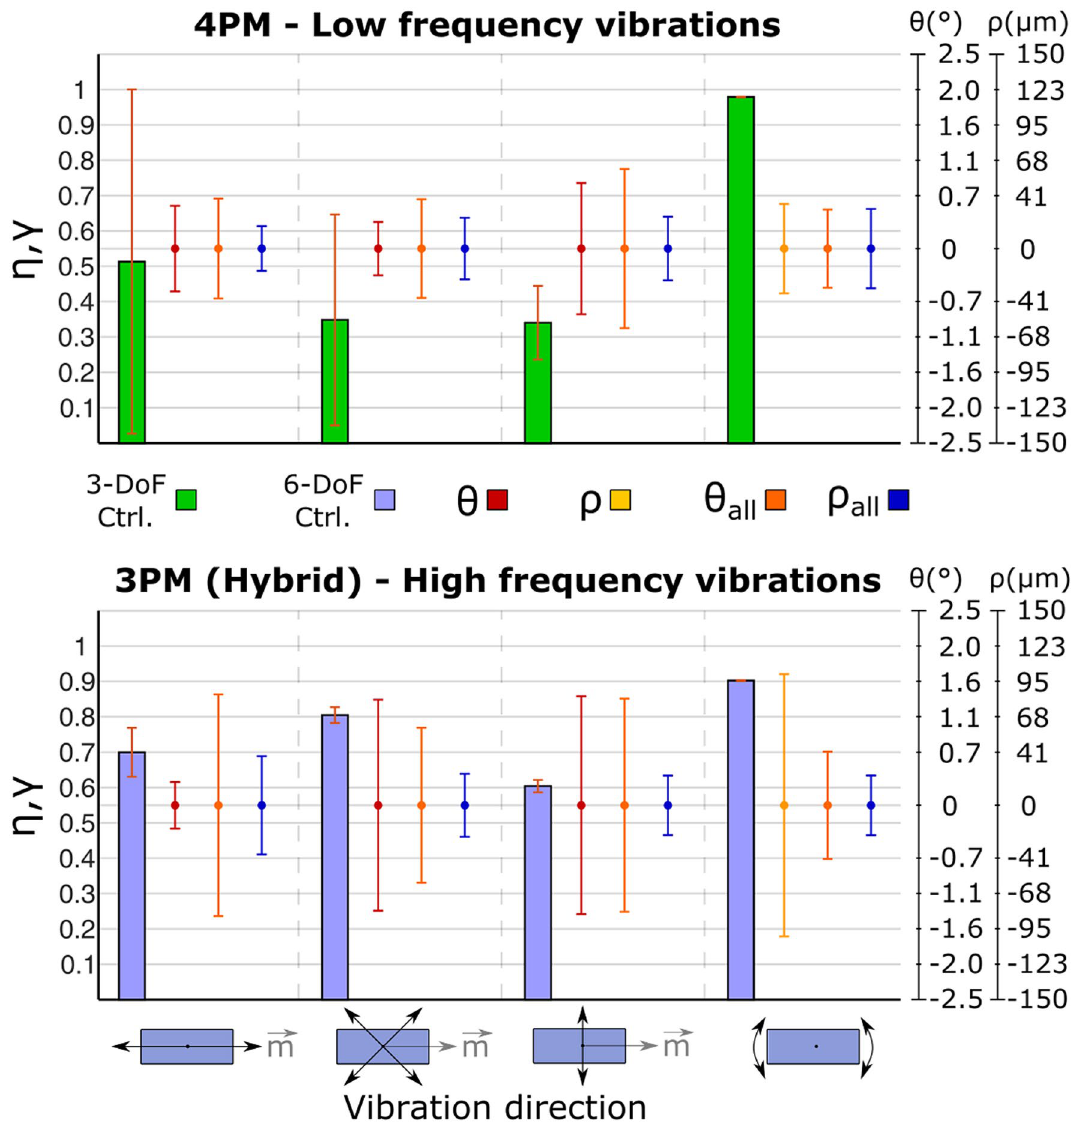
Figure 8. Efficiency and deviation for the four (Group IV) and three (Group V) magnets 12-DoF control tests. In all cases, one magnet was moved along directions indicated with black arrows (3-DoF control for Group IV and 6-DoF control for Group V) and all other magnets were kept still under a 3-DoF control. Bar plots (mean ± standard deviation) indicate the efficiency ( η , γ ) of the movements generated on the moved magnet. The dots (mean ± standard deviation) indicate the displacement signal for the moved ( θ or ρ , depending on the test condition) and still ( θ all , ρ all )